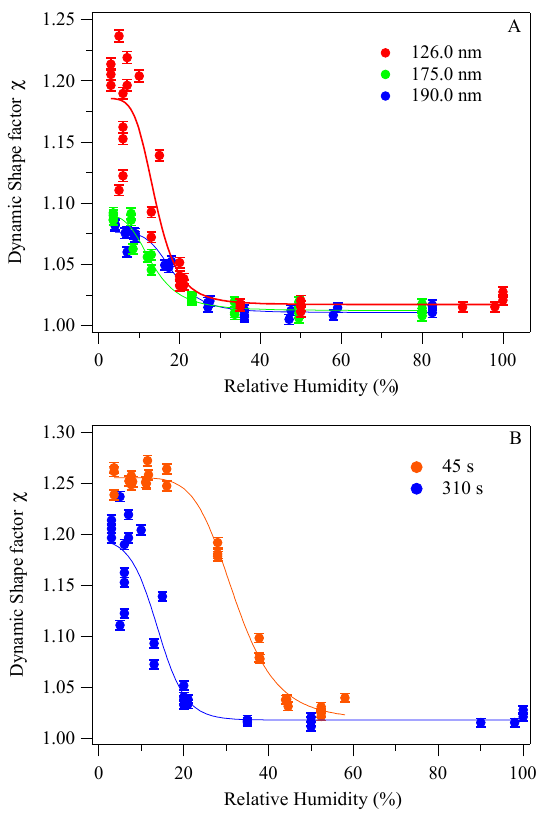
Figure 4. Dynamic shape factor for increasing relative humid- ity. (a) Particles produced from 700ppb α -pinene and 14, 25, and 30ppm ozone for particle populations having central mobility di- ameters of 126.0, 175.0, and 190.0nm, respectively. The exposure time to relative humidity was 310s. (b) Exposure up to 100%RH for 45 or 310s. SOM was produced from 700ppb α -pinene and 14ppm ozone at < 5%RH. The error bars in each panel represent two sigma of standard deviation. The lines represent empirical fits to the data to guide the eye.